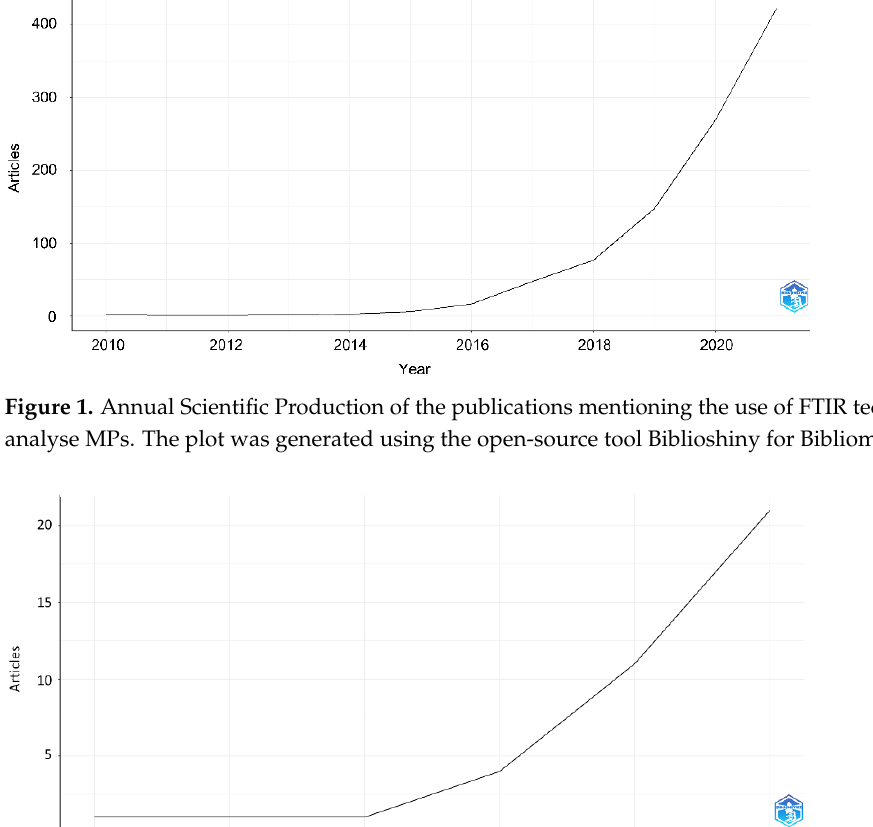
to 12.73, respectively. This indicates the increasing use and popularity of the NIR tech-